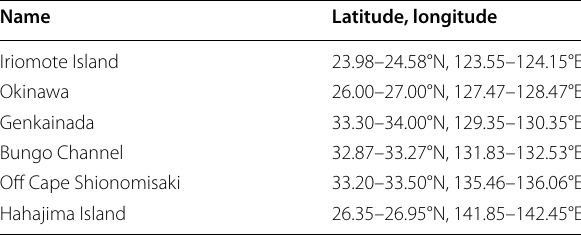
Table 1 Target areas selected for the first particle